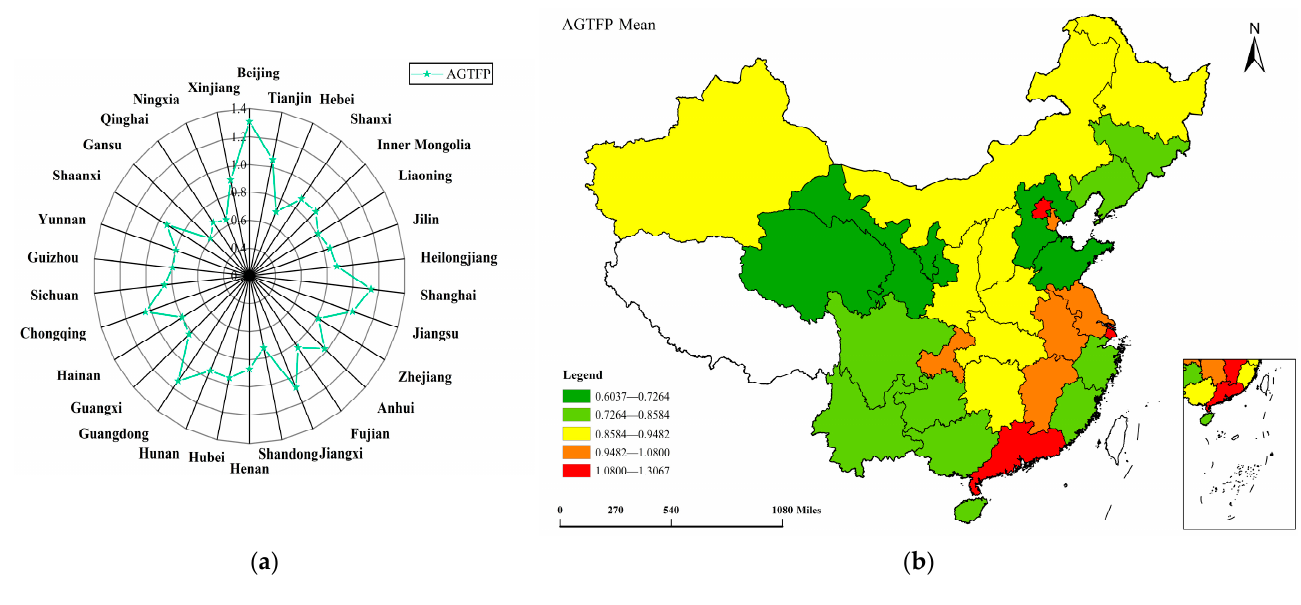
Figure 3. The regional distribution characteristics of AGTFP. ( a ) Radar map of AGTFP mean value of each region; ( b ) spatial map of AGTTP.